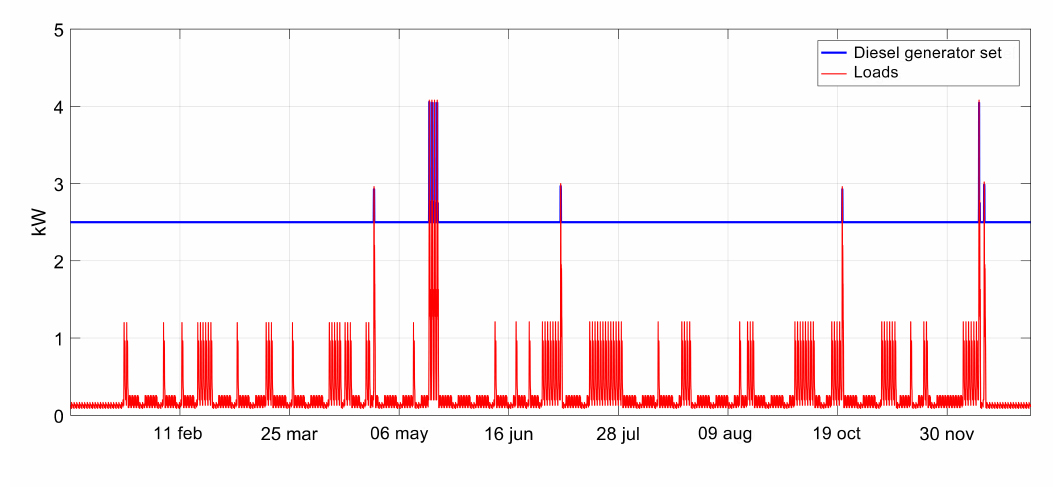
Figure 12. System powered only by diesel to feed the